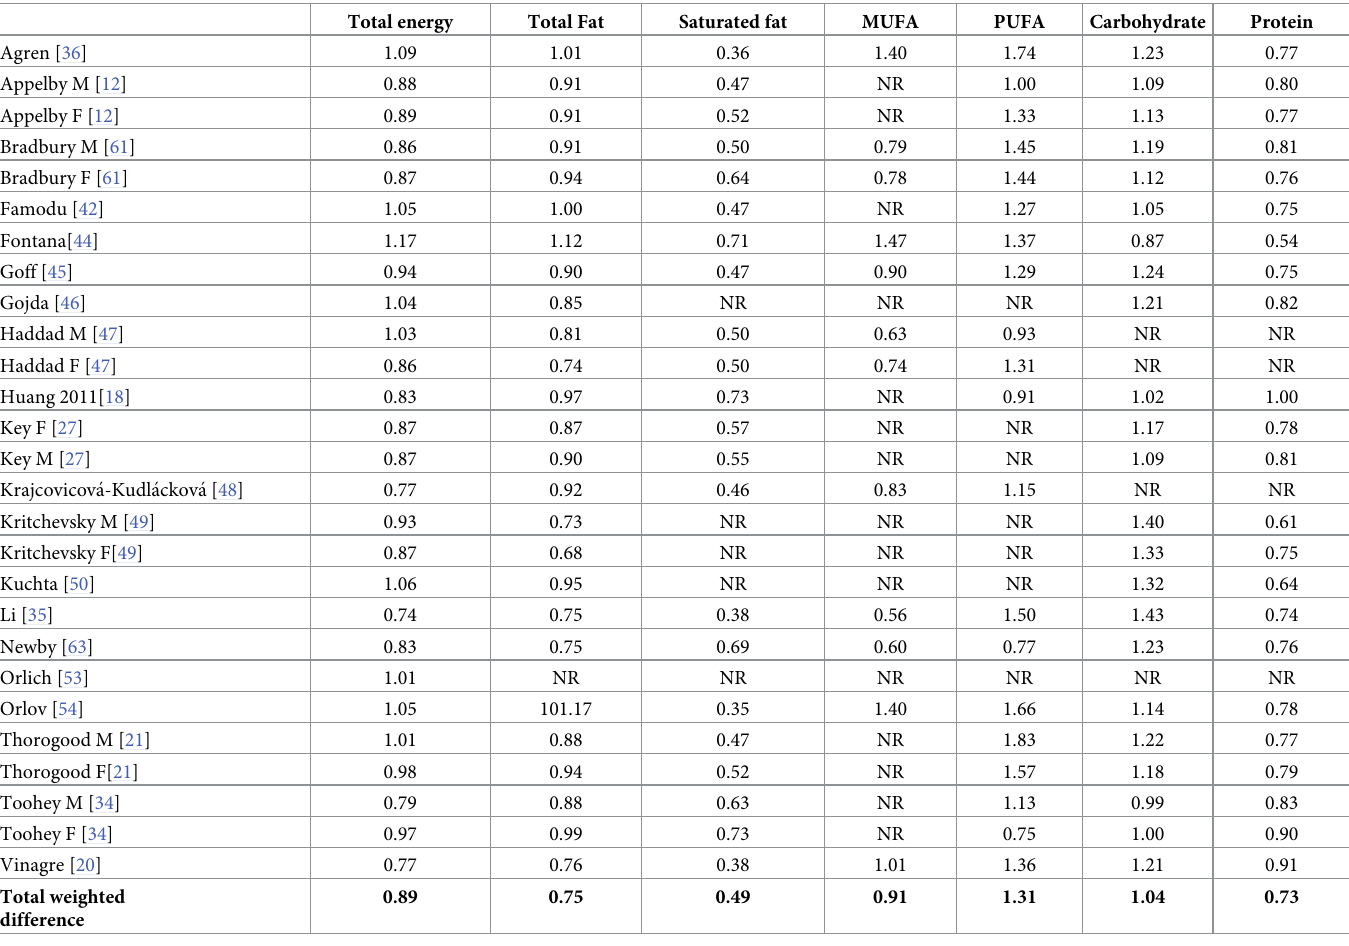
Table 3. Proportional intake of macronutrients in vegans compared to